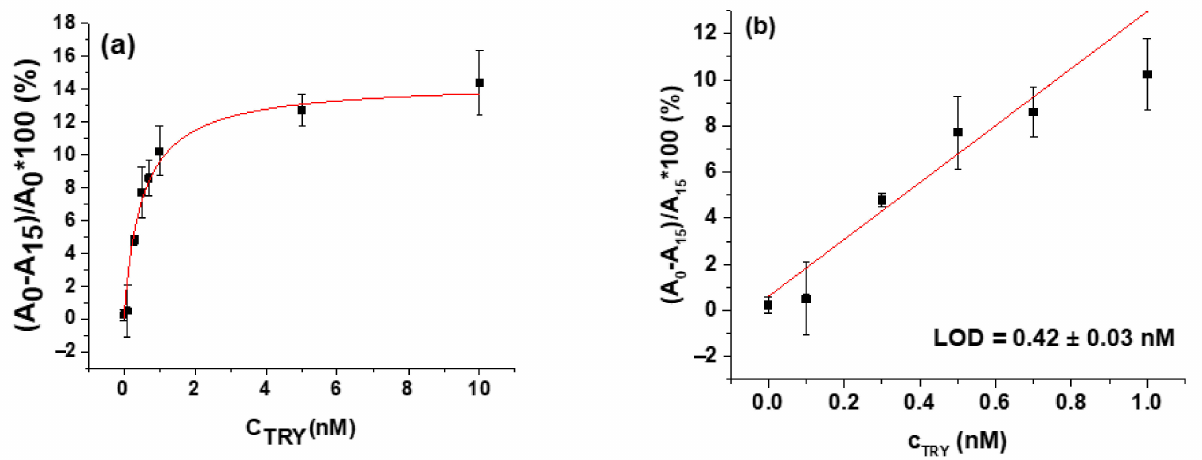
Figure 7. Calibration plots of colorimetric assay. ( a ) Changes in relative values of absorbance after β -casein and MCH functionalized AuNPs (AuNPs/MCH- β -casein) exposure to trypsin (A 0 —exposure time 0 min, A 15 —exposure time 15 min.) vs. concentration of trypsin (C TRY ). Black squares are experimental data, and the red line is the best fit of reverse Michaelis–Menten model ( b ) Linear part of the calibration curve for calculation of the limit of detection (LOD). Values are means ± SD (n = 3). Red line is the linear regression fit. Reproduced from [90].